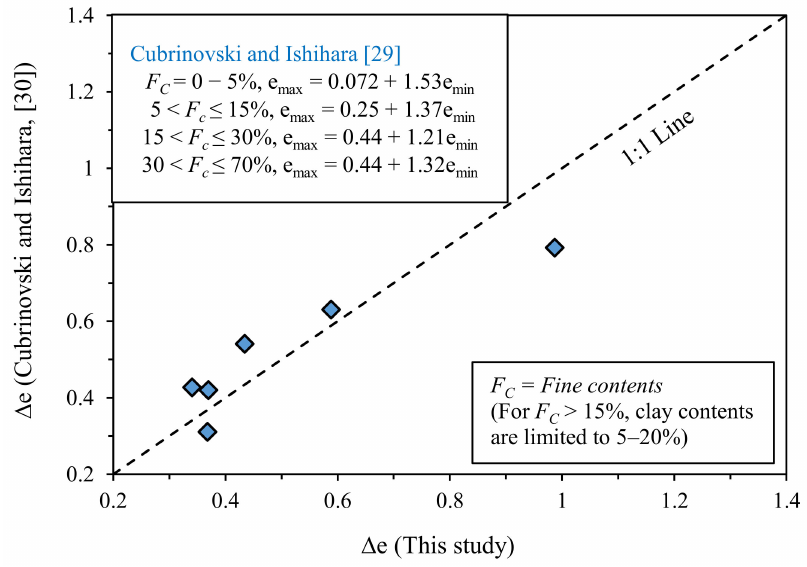
Figure 4. Comparison of void ratio range, ∆